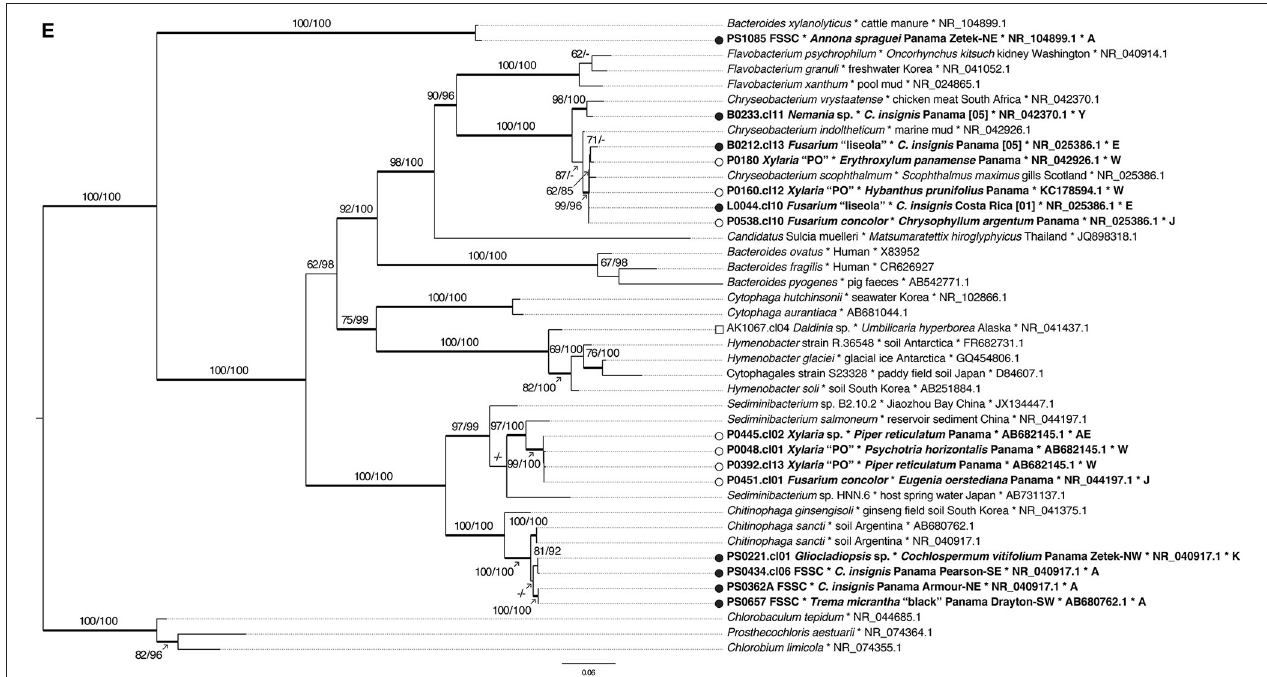
FIGURE 5 | Phylogenetic relationships among EHB based on analysis of 16 S rRNA. (A) Rhizobiales (Alphaproteobacteria); (B) Burkholderiales (Betaproteobacteria); (C) Enterobacteriaceae, (D) Pseudomonadales (Gammaproteobacteria); (E) Bacteroidetes. Topologies represent results from maximum likelihood analyses. Phylogenetic analyses and annotations of node support were carried out as for fungi. EHB from tropical seed-associated fungi are preceded by a black circle. EHB from tropical foliar endophytic fungi are preceded by a white circle. Taxon labels for all EHB observed in this study are bolded, show the host fungus, host plant, geographic origin, GenBank accession numbers for top BLAST matches, and letters indicating host fungal OTUs (95% ITS rDNA similarity). Reference EHB from temperate, foliar endophytic Ascomycota are preceded by white squares and taxon labels are as above but lack letters indicating host fungal OTUs. Reference EHB of root-associated Mucoromycotina, Mortierellomycotina, and Glomeromycota (MMG) are preceded by gray squares. Taxon labels for those latter sequences and for non-EHB references include hosts and geographic origins (when available) and GenBank accession numbers. C = Cecropia . FSSC = Fusarium solani species complex. Double- and triple-hash marks indicate branches shortened to one-half and one-quarter of their length,